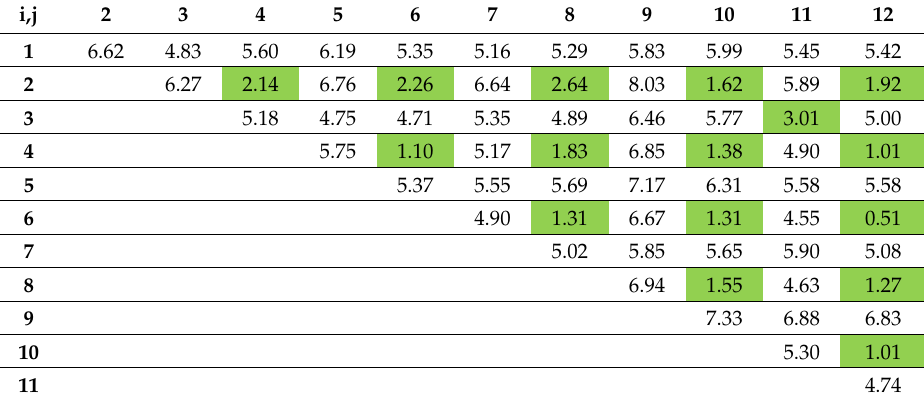
Figure 6. Multipath bins estimated in spoofing scenario 1 for signals related to SVIDs 1-6 ( a – f ). Table 4. Distances between steering vectors in spoofing scenario Each signal from GPS satellite had a different code phase and Doppler shift. Simulated spoofing